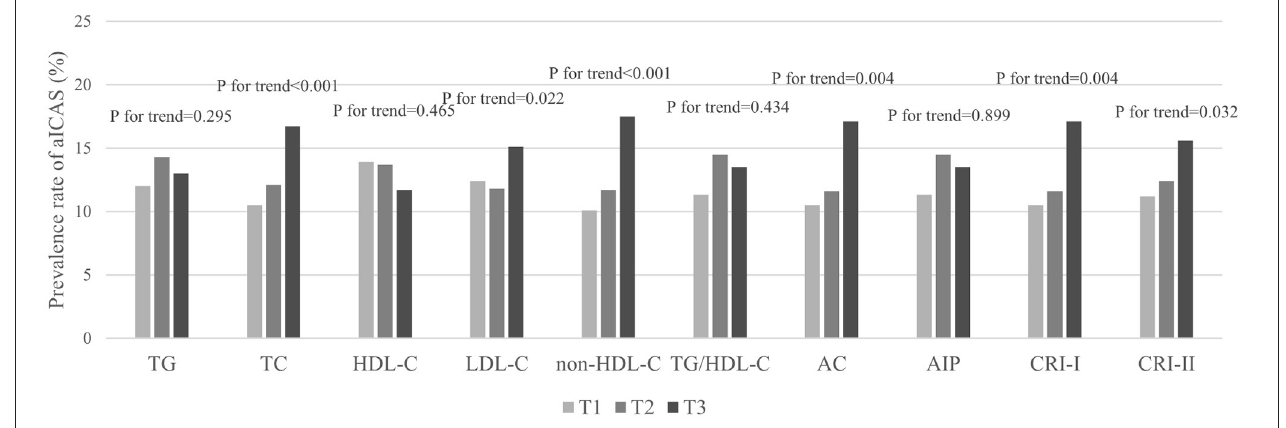
FIGURE 2 | Prevalence rate of aICAS in tertiles of different lipid